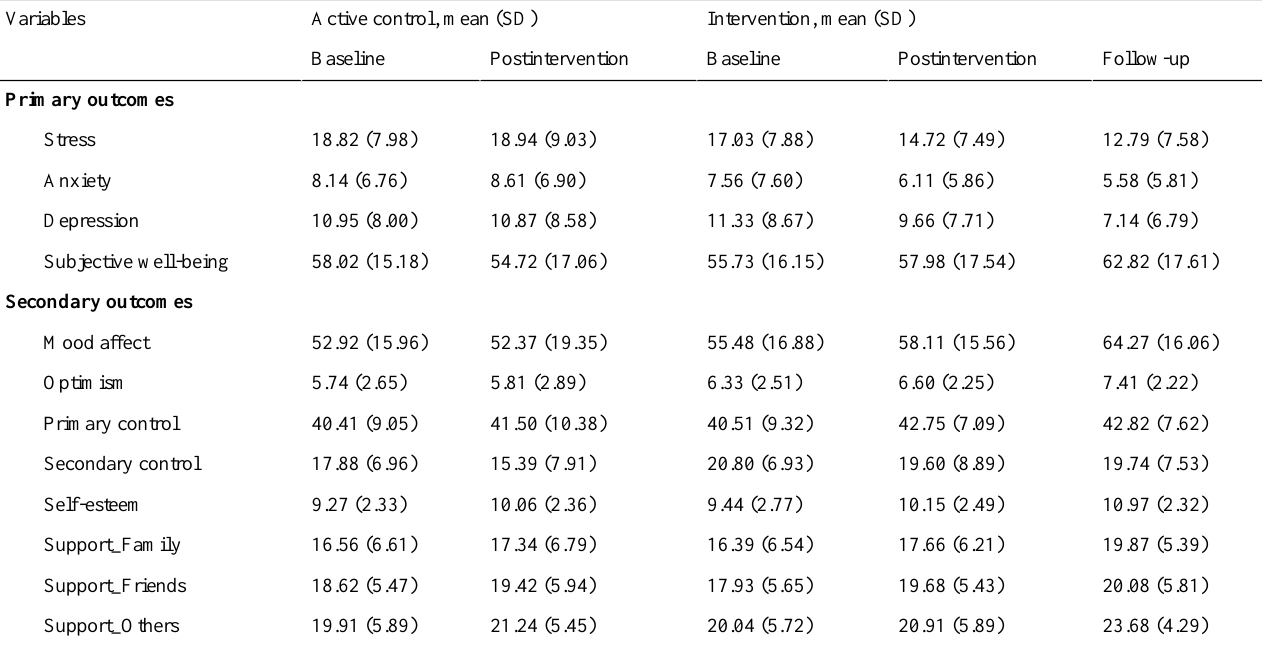
Table 2. Descriptive statistics by group and time point for primary and secondary outcomes.